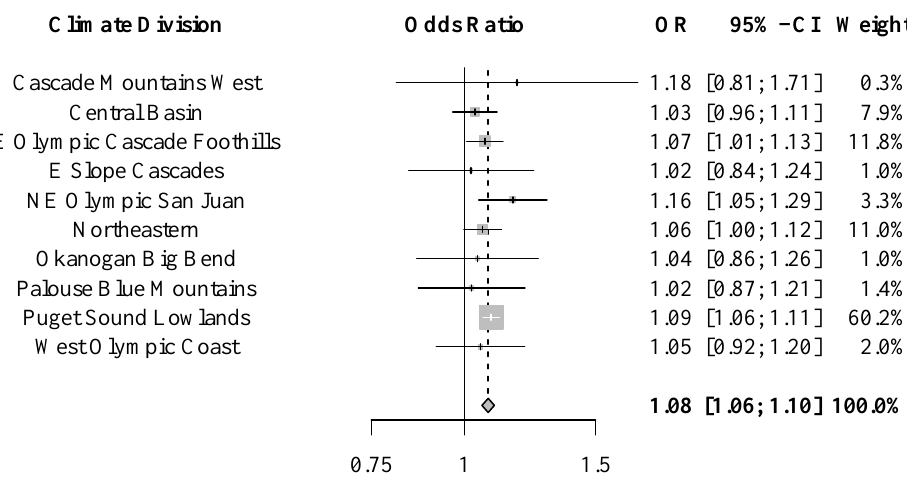
Figure 2. Humidex–mortality exposure–response curves for each of Washington’s climate divisions: ( a ) Cascade Mountains West, ( b ) Central Basin, ( c ) E Olympic Cascade Foothills, ( d ) East Slope Cascades, ( e ) NE Olympic San Juan, ( f ) Northeastern, ( g ) Okanogan Big Bend, ( h ) Palouse Blue Mountains, ( i ) Puget Sound Lowlands, and ( j ) West Olympic Coast.